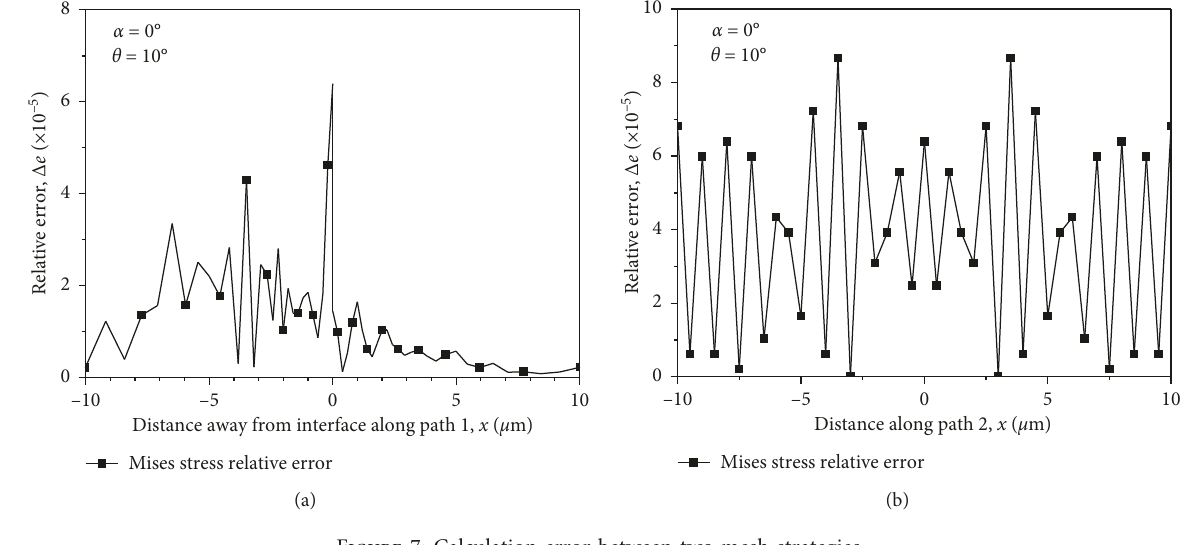
Figure 7: Calculation error between two mesh